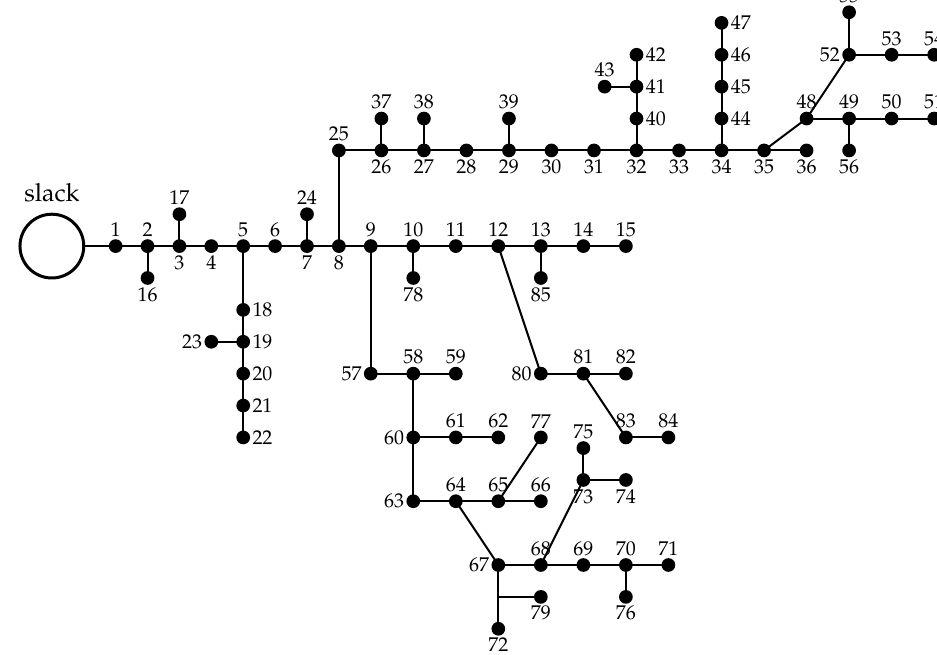
Figure 2. Electrical configuration of the 85-bus system for bipolar DC network